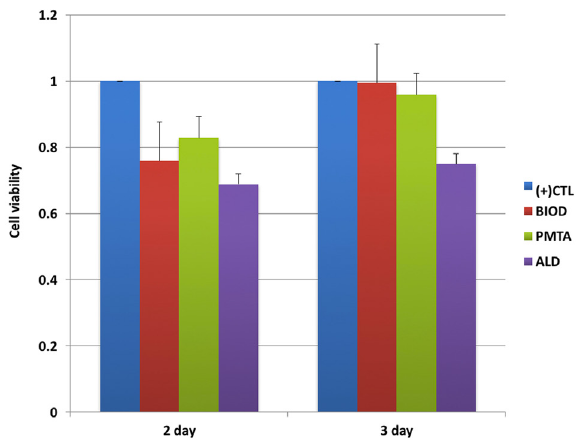
Figure 2- Bone marrow macrophages (BMMs) were incubated with drug-treated media for 48 h or 72 h, after which the viability of cells was assessed using a WST assay. Treatment with Biodentine (BIOD), ProRoot MTA (PMTA), or alendronate (ALD)